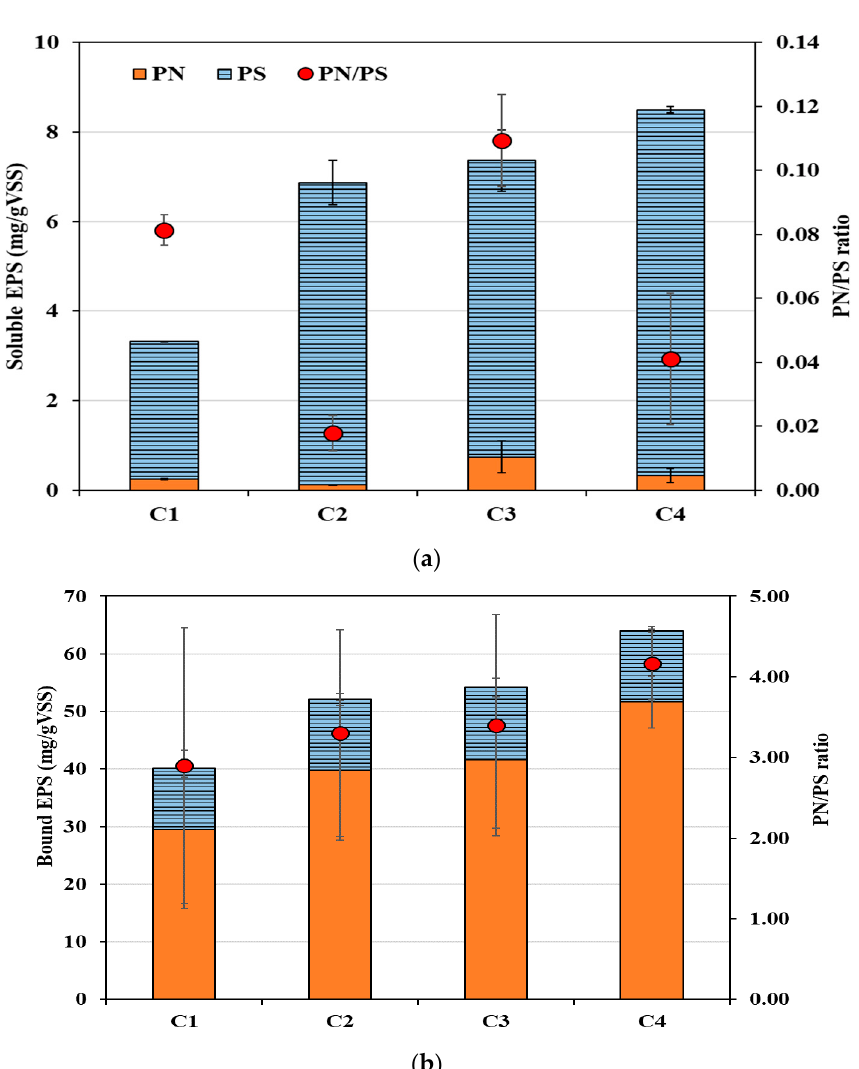
Figure 4. PS and PN concentrations, and PN/PS ratio in soluble EPS ( a ) and bound EPS ( b ) anammox granules at C1 (no salt and no cation), C2 (5 g NaCl/L and no cation), C3 (5 g NaCl/L and 200 mg/L Ca 2+ ), and C4 (5 g NaCl/L and 70 mg/L Mg 2+